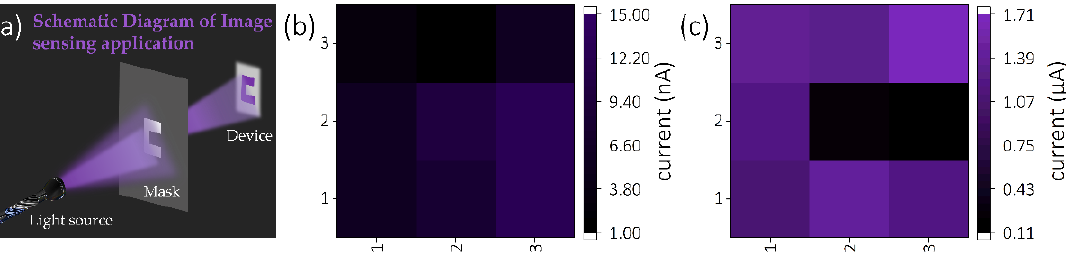
Figure 4. ( a ) Schematic diagram of the imaging system; ( b ) two-dimensional dark current contrast diagram; ( c ) two-dimensional imaging current contrast diagram.